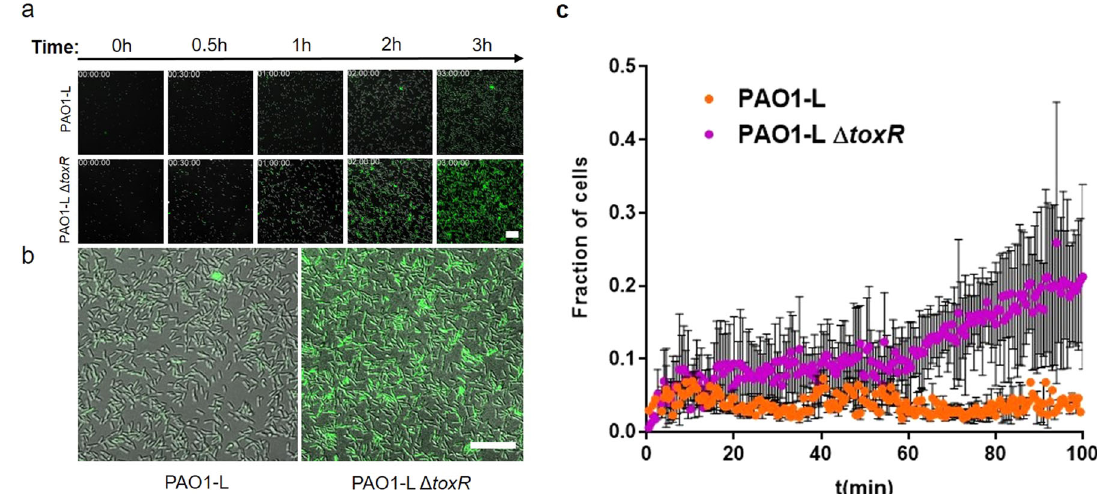
Fig. 6 ToxR has a negative impact on cdrA expression as an indirect measurement of free c-di-GMP levels. a Fluorescence output of P cdrA gfp -expressing PAO1-L and Δ toxR cells as they transition from liquid culture to glass surface over time (3 h). Scale bar: 20 µm. b Representative combined Differential Interference Contrast (DIC) and wide fi eld epi fl uorescence images of PAO1-L and Δ toxR after 3 h exposure to a glass surface. Scale bar: 27 µm. c Graph shows the fraction of cells expressing P cdrA -gfp (ASV) C over time for the fi rst 100 min after attachment to a glass surface. Dots represent mean ±1 SEM ( n = 3).